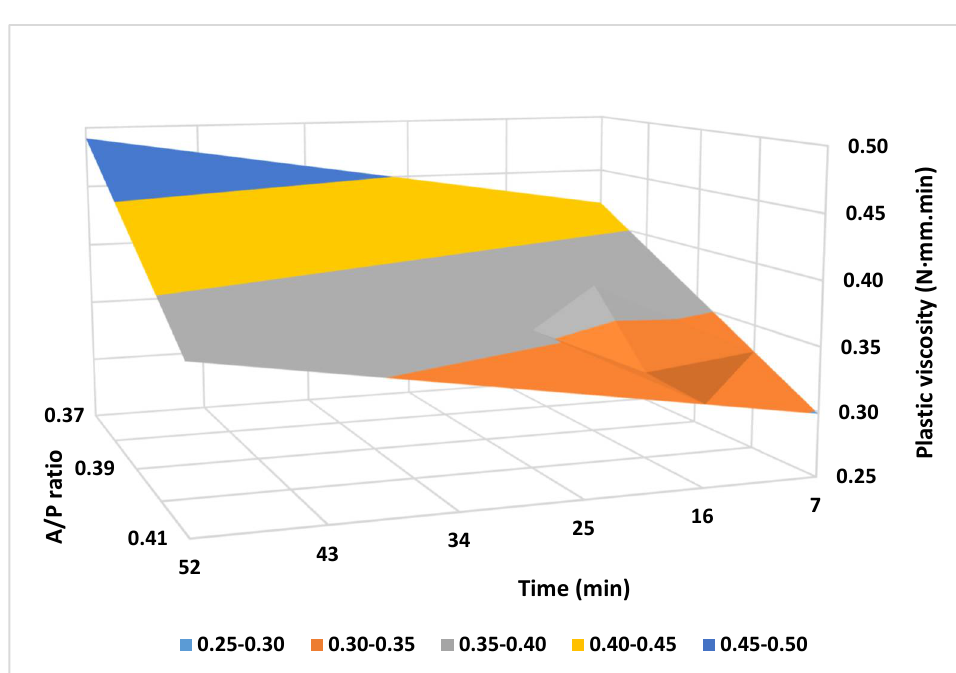
Figure 8. Relative plastic viscosity as a function of A/P ratio and time.